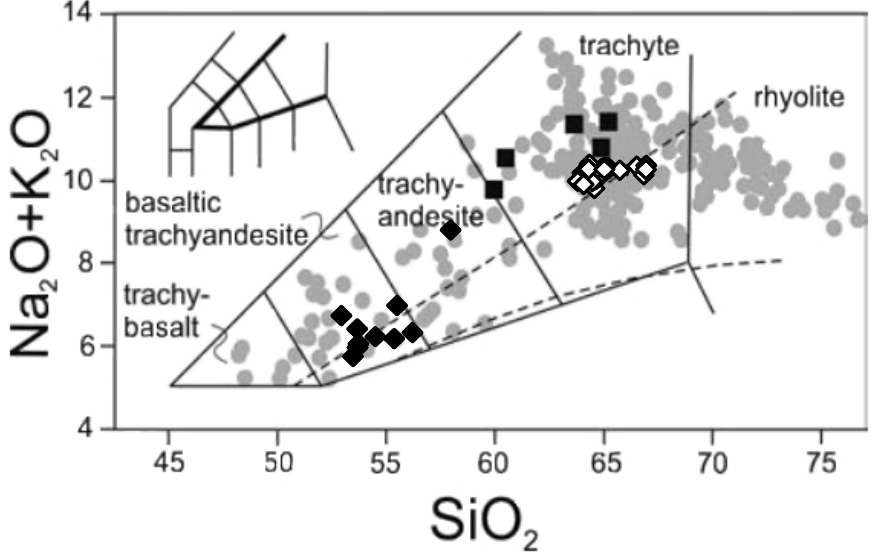
Figure 2. Total-Alkali versus Silica (TAS) classification diagram [31] for the Euganean Hills dataset. Symbols: grey circle Euganean lavas (see [6]); black square: crystal mushes enclaves from [6]; open diamond: trachyte host from [32]; and black diamond: enclaves from